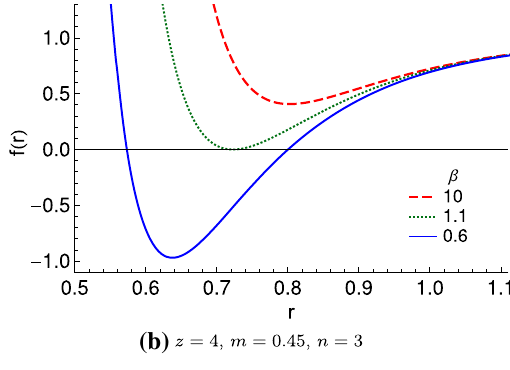
Fig. 1 The behavior of f ( r ) versus r for l = 1, b = 0 . 8 and q = 1 .